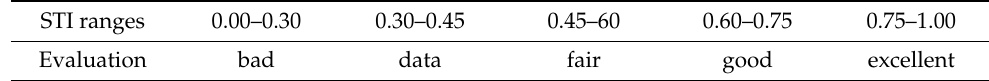
Table 5. STI values and their corresponding evaluation.